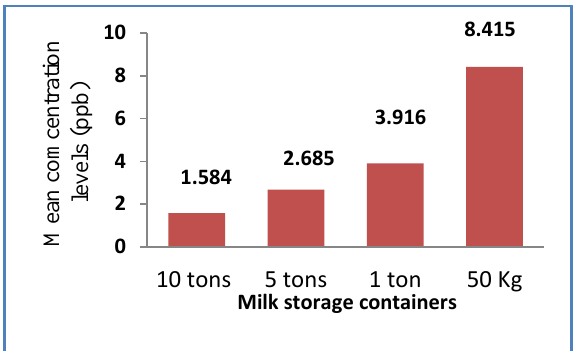
Figure, 1: Differences in the mean levels of all eight different antibiotics residues between milk containers of different capacities for both